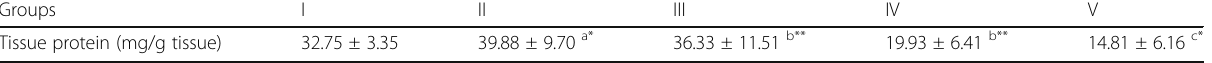
Table 2 Effect of aqueous extract of Caesalpinia bonducella L. on tissue protein in experimental animals